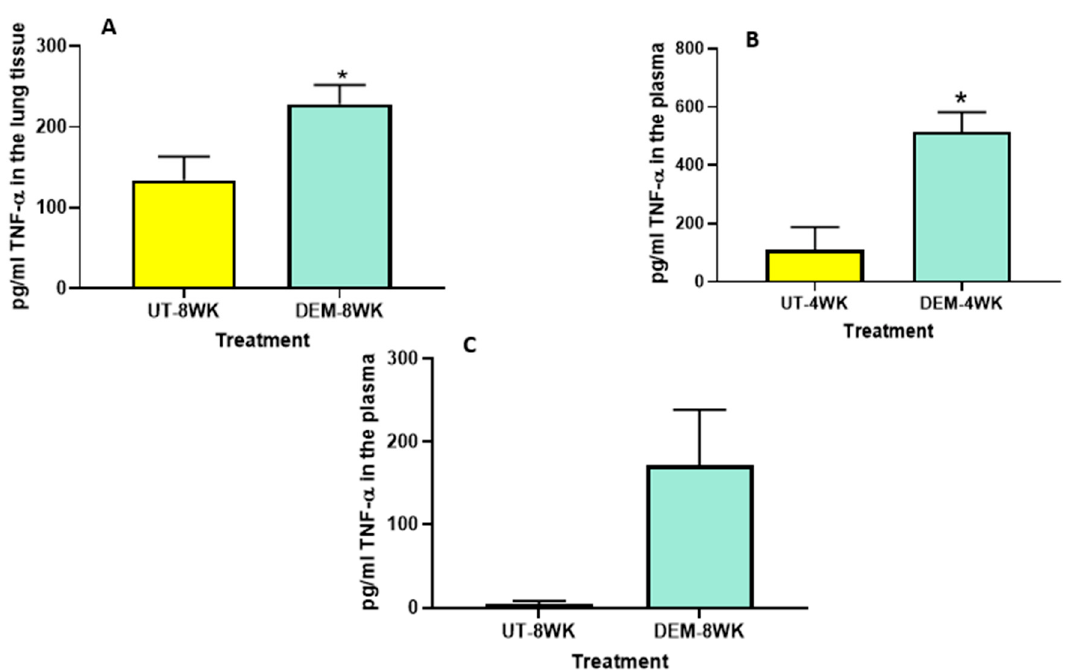
Figure 3. Measurement of TNF- α in the lung lysates and plasma of M. tb infected mice that were sham-treated or treated with DEM. Levels of TNF- α were measured in the lung lysates at 8 weeks ( A ) post-infection and in the plasma at 4 weeks ( B ) and 8 weeks ( C ) post- M. tb infection. Statistical analysis was performed using GraphPad Prism software. Unpaired t tests were performed using Welsch correction. All values reported are representative of the mean values for each respec- tive category and a p -value of <0.05 was considered significant. Any placement of an asterisk (*) denotes a direct compar- ison of the DEM-treated versus the untreated category. The sample size ( n ) includes six mice each in the untreated and DEM-treated groups.